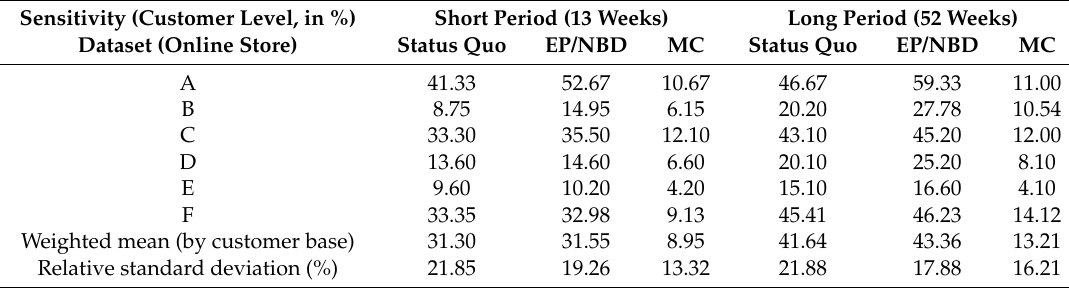
Table 6. Results for Sensitivity (customer level, in